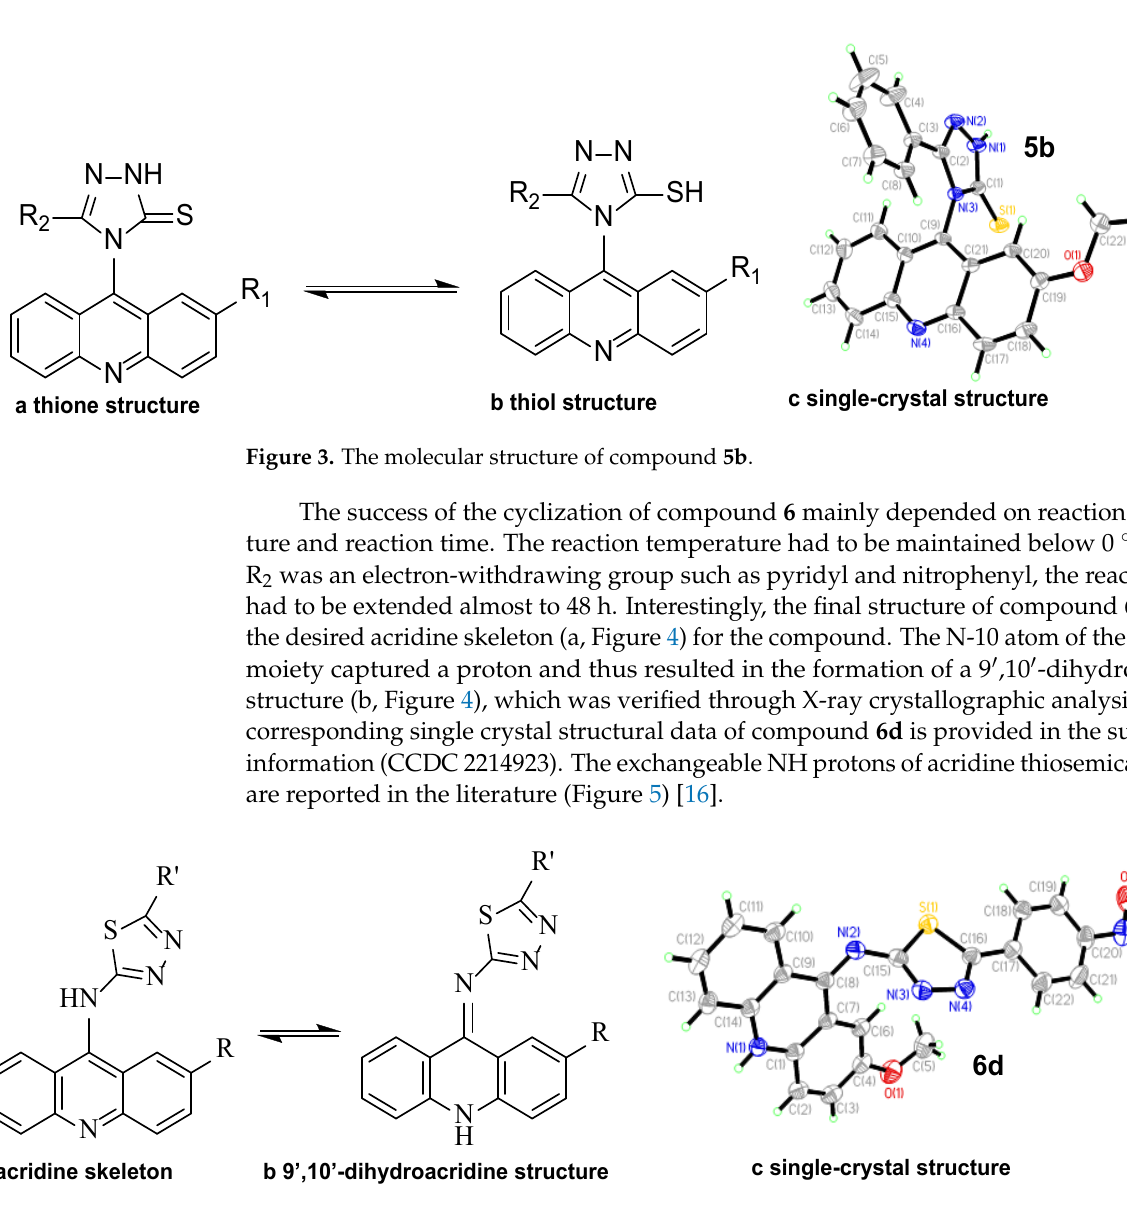
Figure 4. The molecular structure of compound 6d.